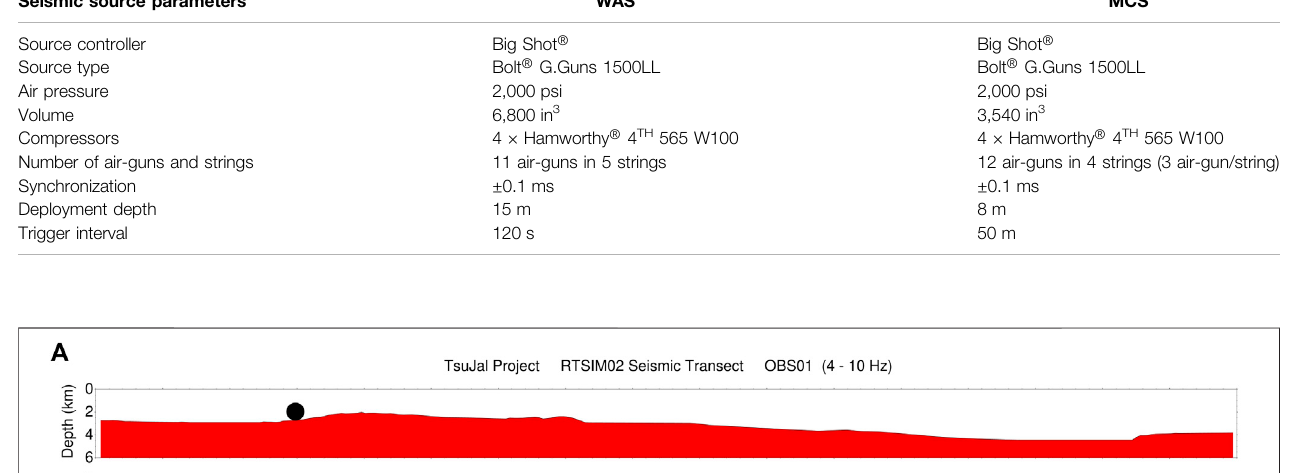
TABLE 1 | Seismic source parameters used during the RTSIM02 wide-angle (WAS) and the TS08 multichannel seismic (MCS) data acquisition. Seismic source parameters